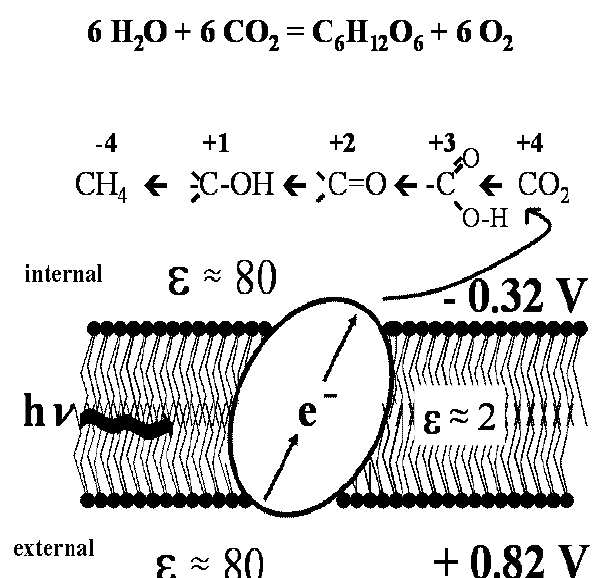
Fig. 2. The role of the reaction centre protein in the charge sepa- ration and stabilization processes in the photosynthetic mem- brane. The free energy of light is used to drive an electron across the membrane in order to create a high reducing power for car- bon